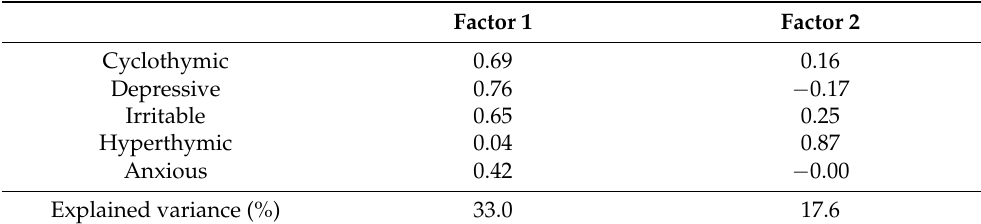
Table 3. Factor loadings for 5 temperaments using exploratory factor analysis (varimax rotation).